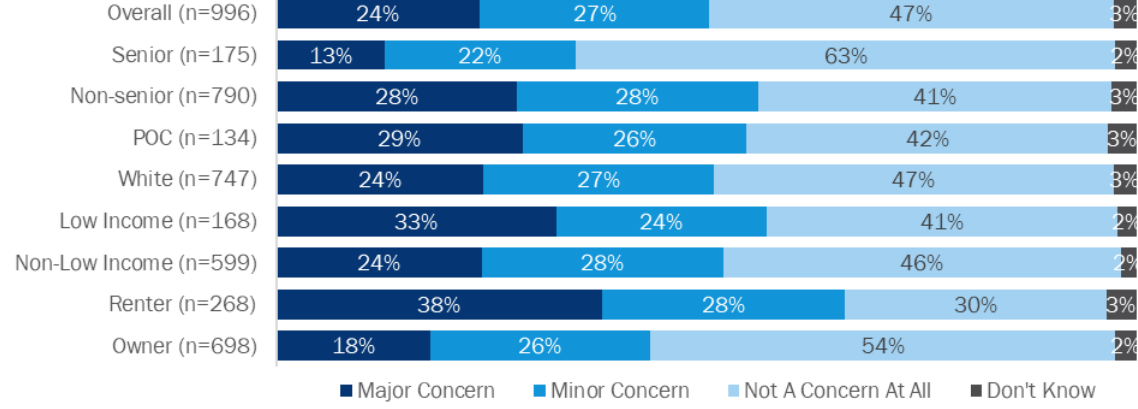
Figure 7. Level of concern about current charging situation on EV purchase decision. Note: The total ns for each demographic group (e.g., seniors + non-seniors) do not always sum to the overall n of 996 because some survey respondents declined to provide demographic information.